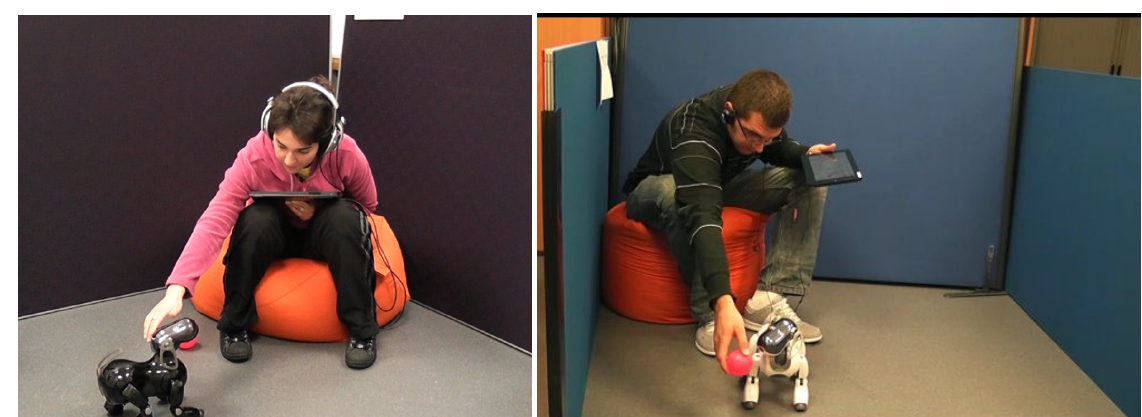
Figure 4. Participants interacting with the AIBOs and the tablet computers in robot